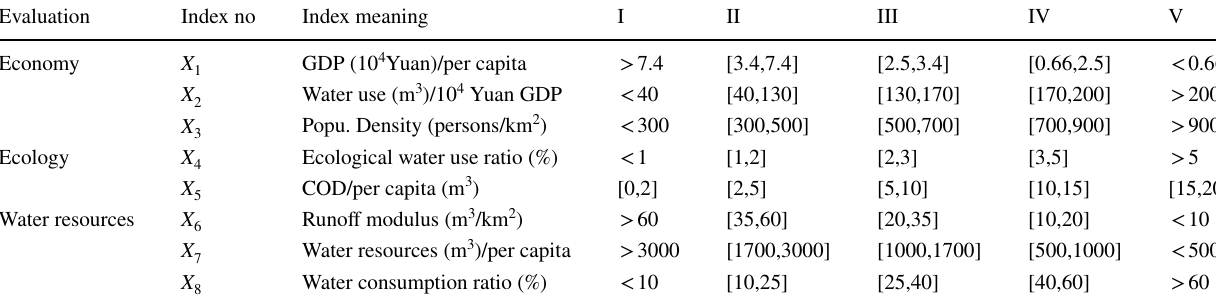
Table2 Evaluation index and classification of water resources capacity in Henan Province